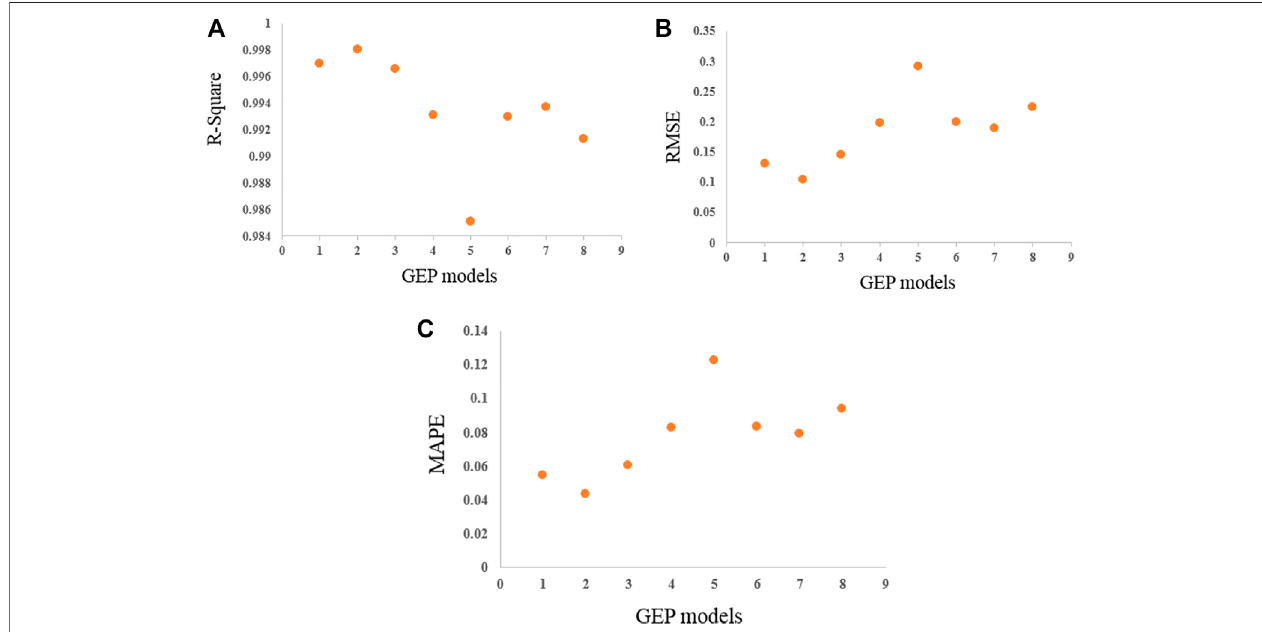
FIGURE 10 | Expression tree of the